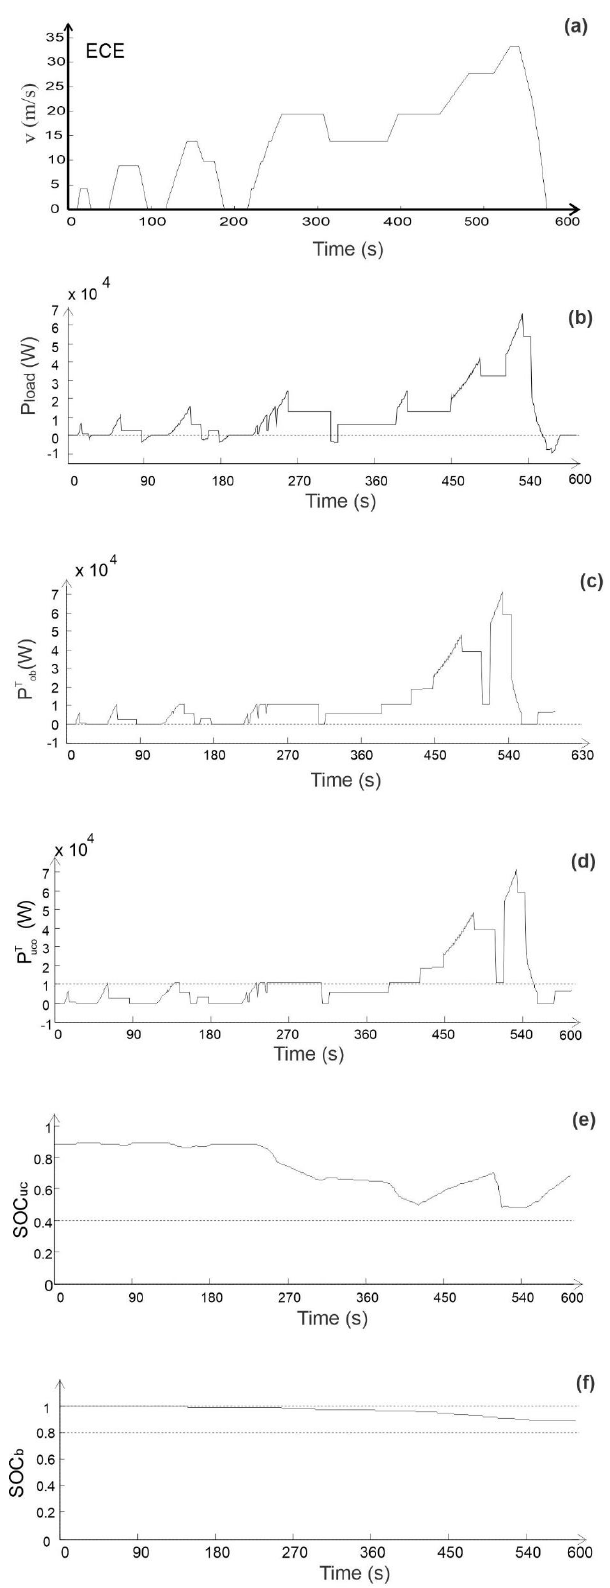
Figure 14. Simulations of the multiple converter configuration in the face of ECE driving cycles. ( a ) Speed profile of the ECE driving cycle; ( b ) vehicle load power profile; ( c ) battery pack power; ( d ) UC bank power; ( e ) UC bank state of charge; ( f ) Battery (B) pack state of